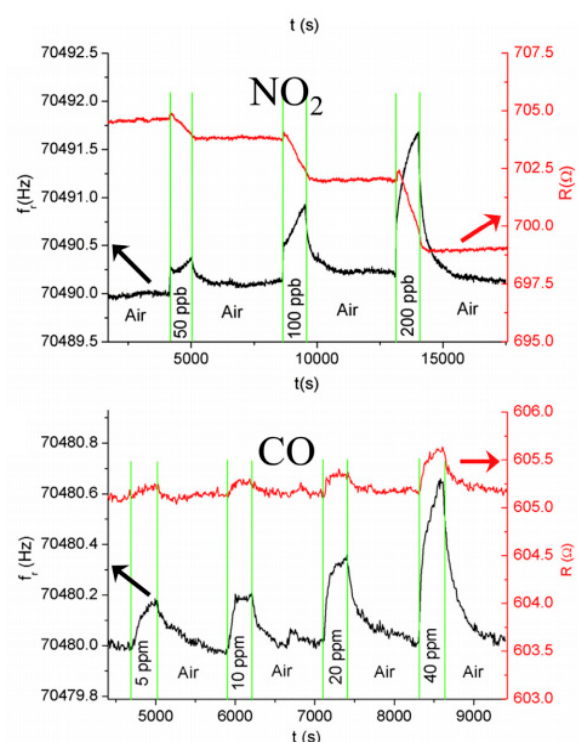
Figure 22. Screen-printed cantilever with multiwalled carbon nanotube functionalized by oxygen-argon plasma as sensitive material. Reproduced with permission from Reference [114].